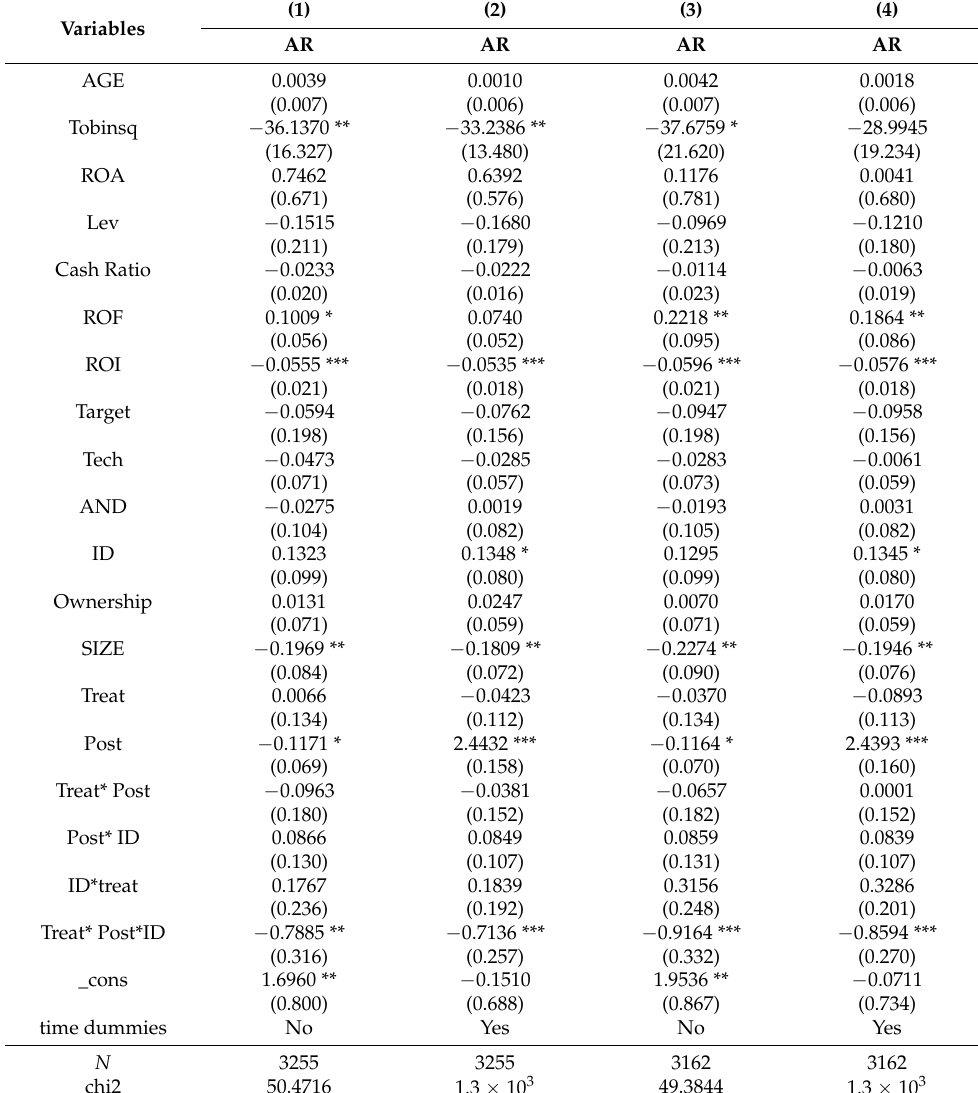
Table 12. Regression results of the moderating effect of innovative medicine-oriented